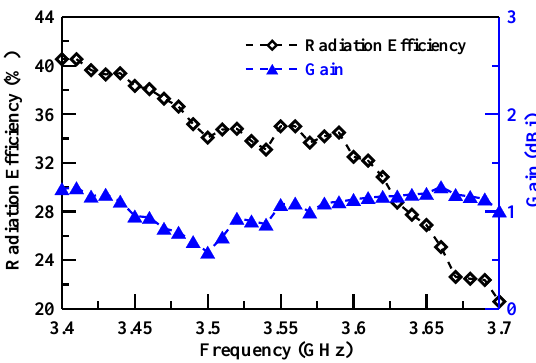
Figure 12. Middle band gain and radiation efficiency measurement results.